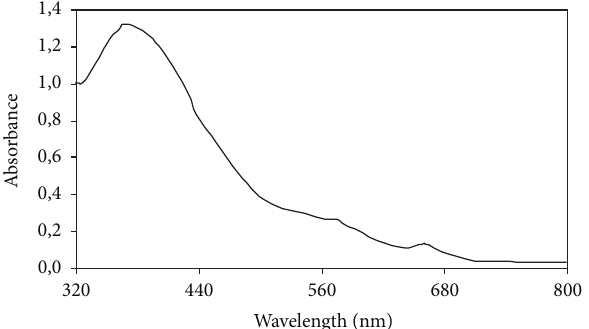
Figure 2: The absorbance spectra of the MeOH/acetone (10:90 v:v) extract of sediment lake at Edmonson Point.